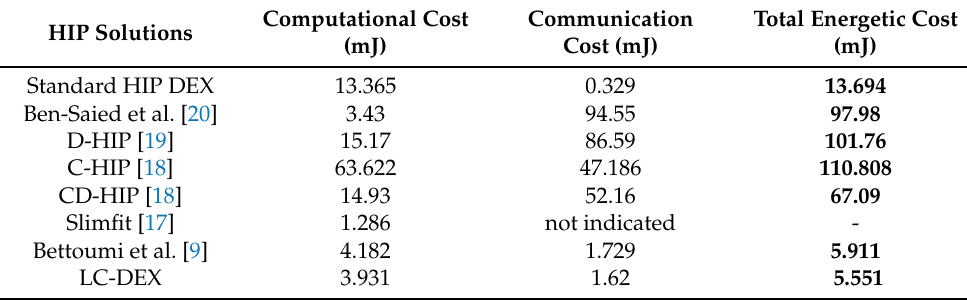
Table 14. Communication and computational energetic costs of HIP existing